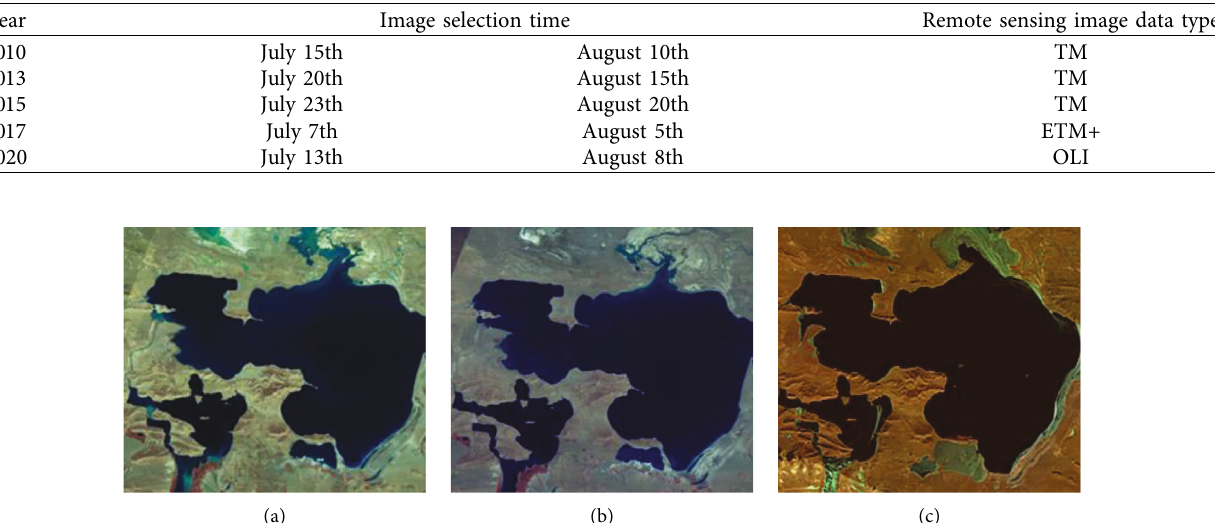
Table 2: Remote sensing image selection time period and data type.